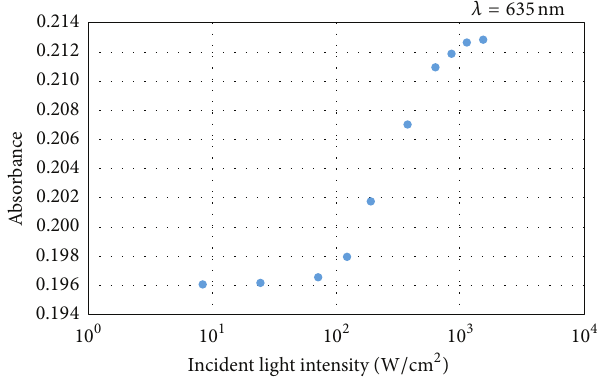
Figure 1: Nonlinear optical characteristic of the absorbance depending on the incident light